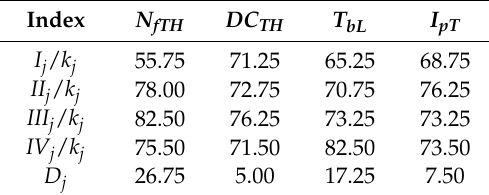
Table 3. Results of the range analysis.